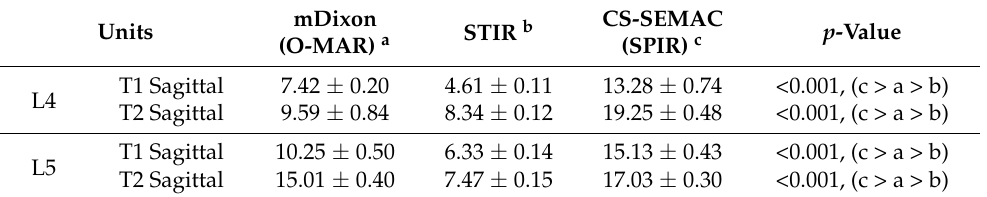
Table 5. CNR result of T1, T2 MAR effect in testing transplant patients.